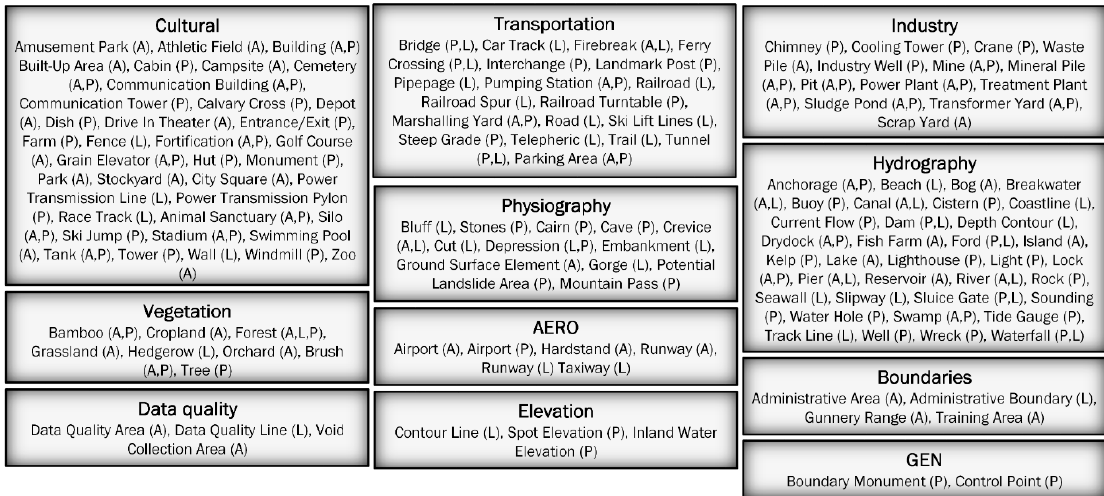
Figure 2. Thematic categories and feature classes in VMap Level 2 (A: Area, L: Line, P: Point object) [23] .